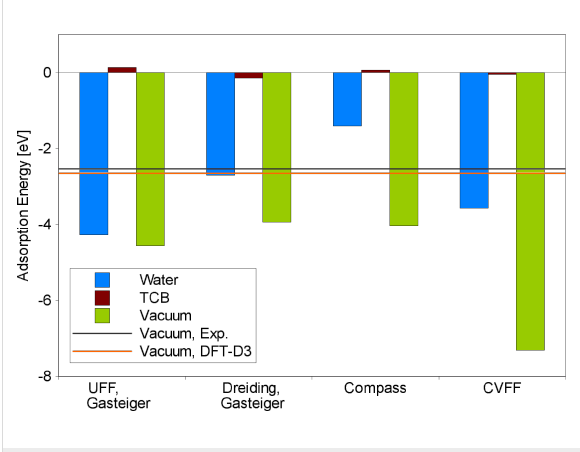
Figure 7: Adsorption energy of a 3,3 ′ -BTP molecule on graphite: under vacuum conditions and at the solid/liquid interface from water or TCB, respectively. Experimental value and DFT-D3 result from [12].